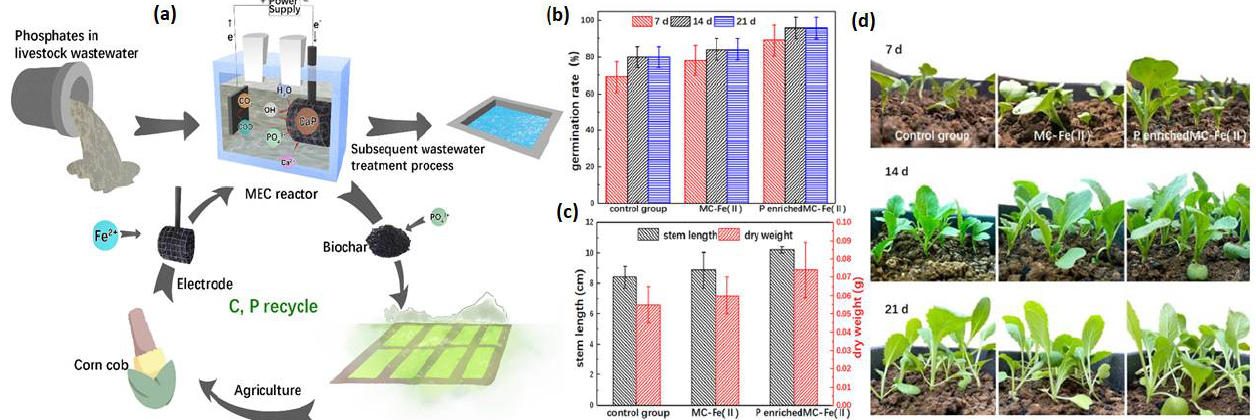
Figure 10. ( a ) Using a biochar-based cathode, MECs recovered phosphorus from wastewater and produced fertilizer. ( b ) On the 7th, 14th, and 21st days, the survival rate of Pakchoi varied by group. ( c ) On the 21st day, the stem length and dry weight of Pakchoi were measured in various groups. ( d ) Pakchoi photos from the 7th, 14th, and 21st days. (Reprinted with permission from [71]. Copyright 2022, Elsevier.)